Question: Give a one-sentence summary of this figure.
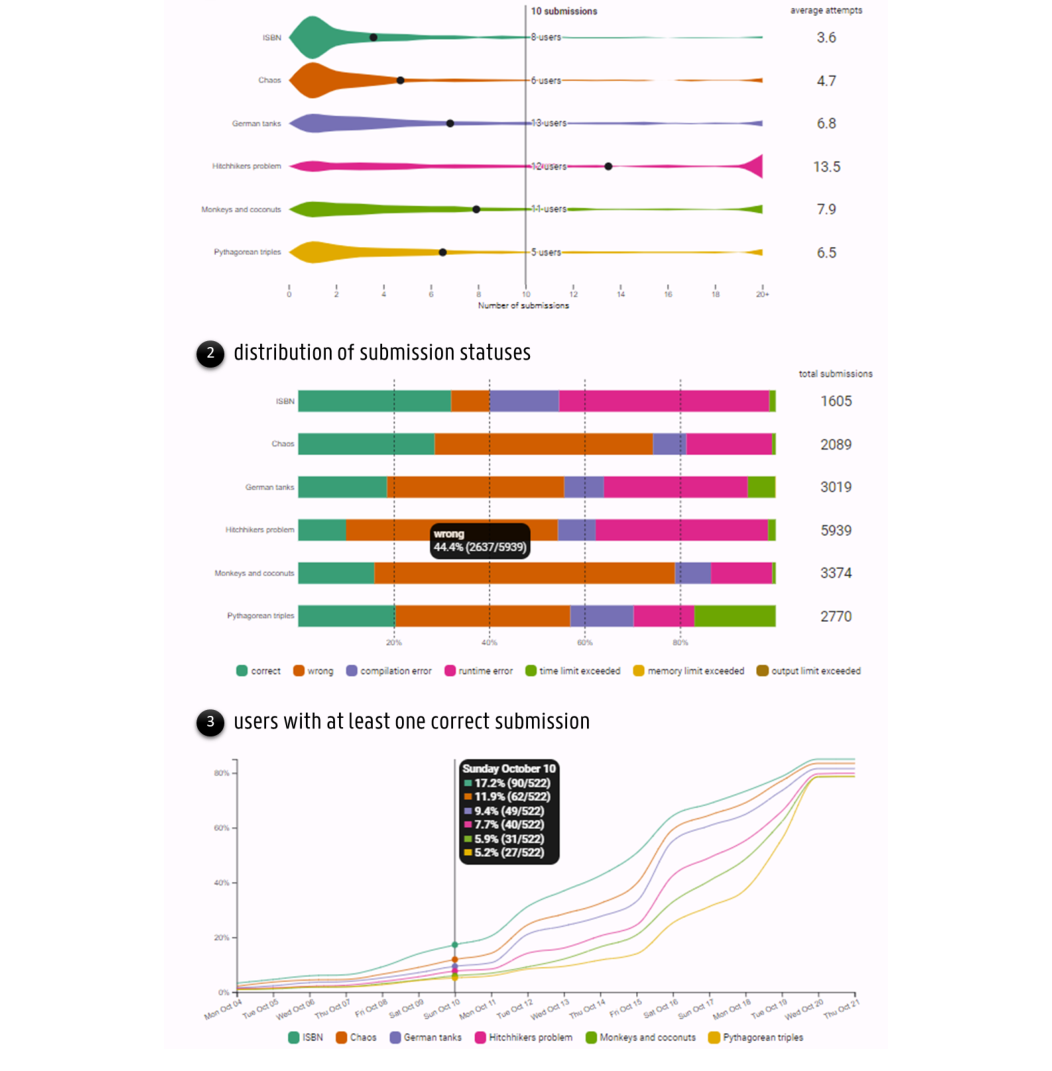
Answer: Interactive learning analytics on student submission behavior across programming assign- ments in the series where (unnested) loops are introduced in the course (2021–2022 edition). Top: Distribution of the number of student submissions per programming assignment. The larger the zone, the more students submitted a particular number of solutions. Black dot indicates the average number of submissions per student. Middle: Distribution of top-level submission statuses per programming assignment. Bottom: Progression over time of the percentage of students that correctly solved each assignment.